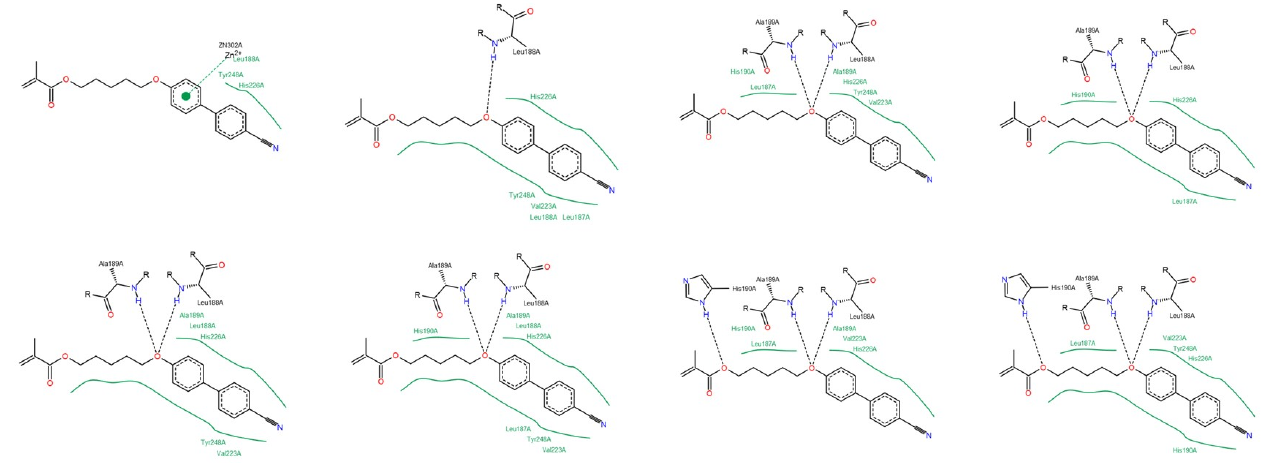
Figure A14. Interactions between compound B and MMP-9, by PoseView calculations.